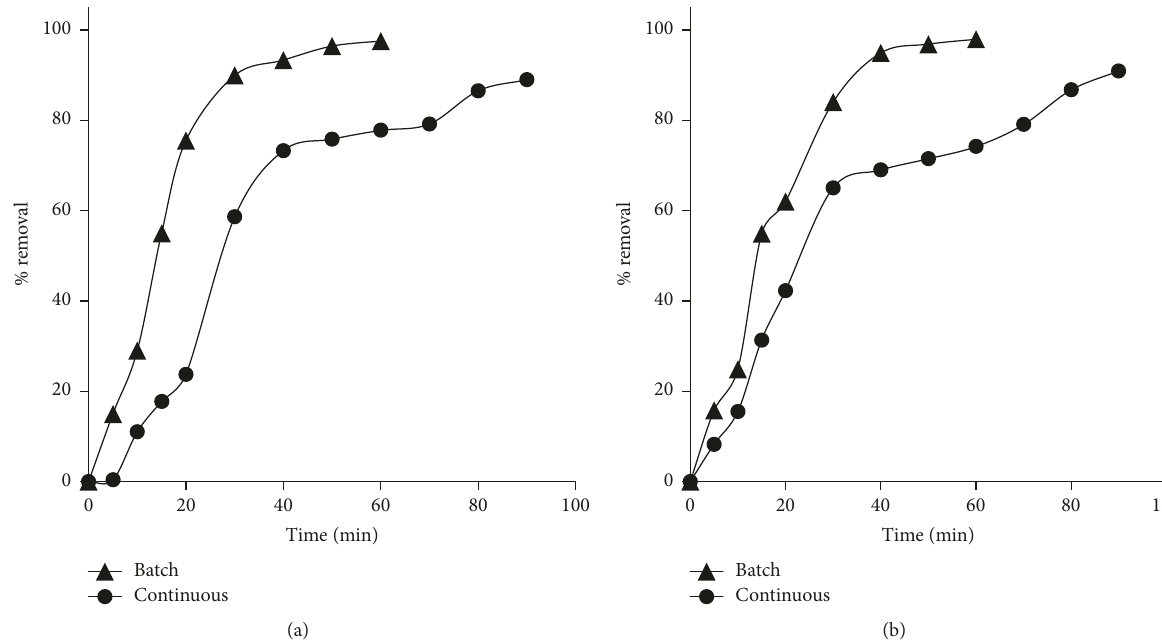
Figure 2: Comparative performance of the batch and the continuous-mode systems in treating (a) malachite green and (b) Remazol yellow with 100 mg/L and current input of 35.7 A/m 2